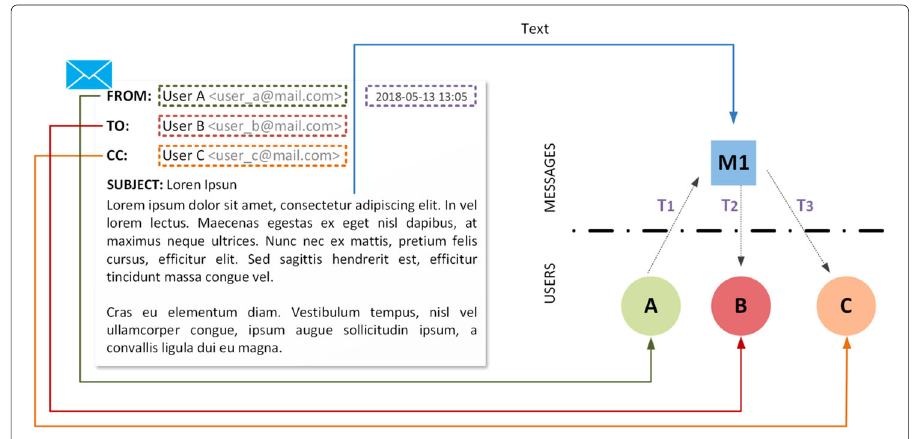
Fig. 4 Model of a multicast email as a temporal text network. The entire text content of the email (including the subject line and the body) are encoded as a single message M 1 . The sender of the email (UserA) and the two friends ( UserB , UserC ) are modeled as individual actors. In this case, the ingoing and outgoing edges of the message contain a different time, indicating the delivery and reception timestamps registered in the email